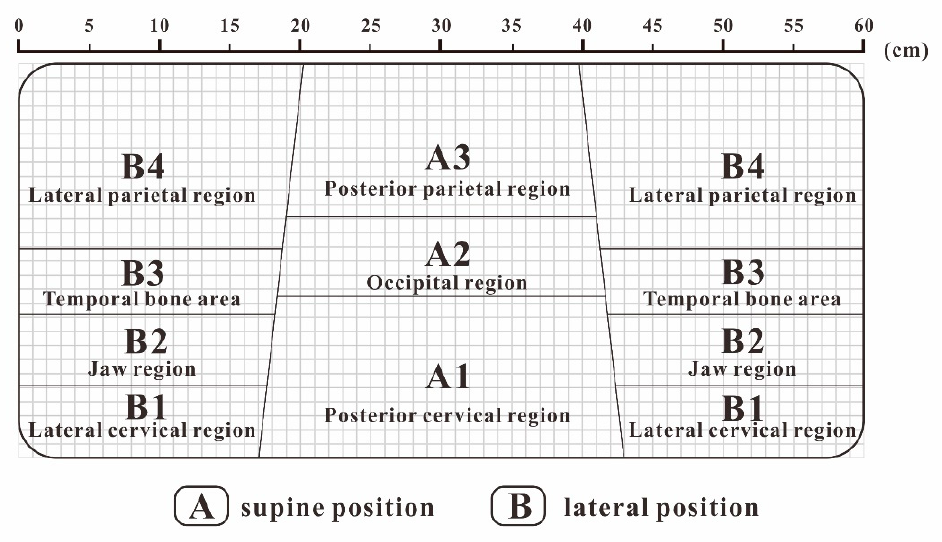
Figure 4. Pillow Figure 4. Pillow partition. Table 4. Partition ideal body pressure distribution index.